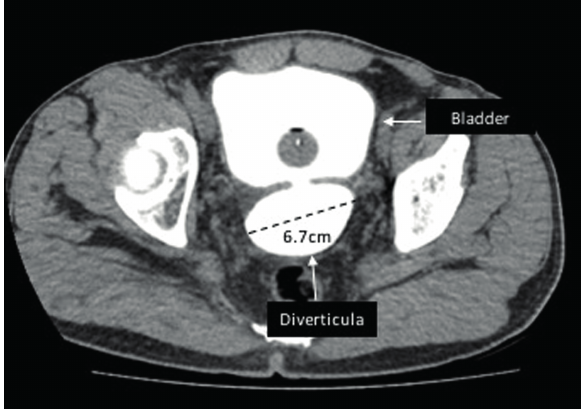
figure 1 - Diverticula assessment. pelvic computed Tomography (cT) with the bladder full of contrast showing posterior diverticula with 6.7cm and a narrow